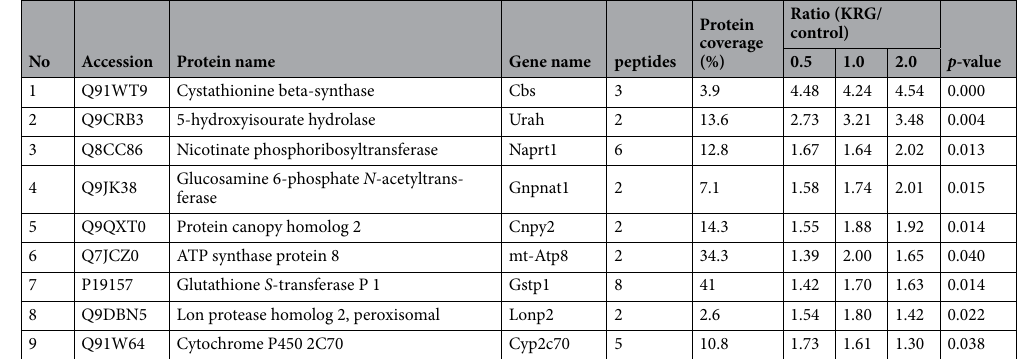
Table 1. List of statistically significant upregulated proteins.